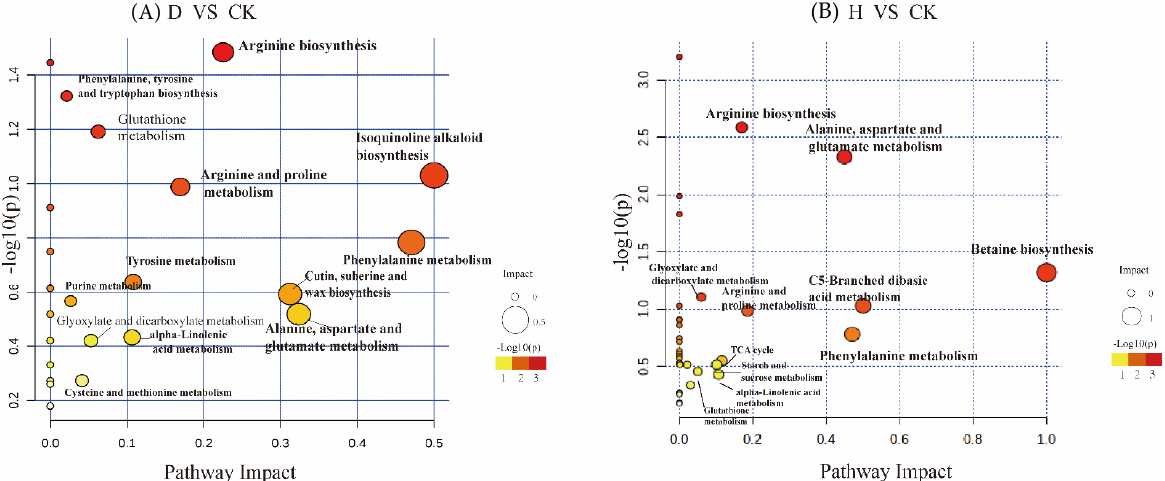
Figure 6. Pathway impact analysis containing ( A ) D vs. CK, ( B ) H vs. CK. The x-axis denotes the pathway impact; the y-axis represents pathway enrichment, the circle size denotes pathway to impact, and the circle color from red to yellow represents the p -value ( p < 0.05) becoming smaller. H treatment: P852 at 10 μ g/mL, D treatment: 1 μ g/mL of P852, and CK: sterile water to treat Fusarium wilt in the roots of Faba bean.